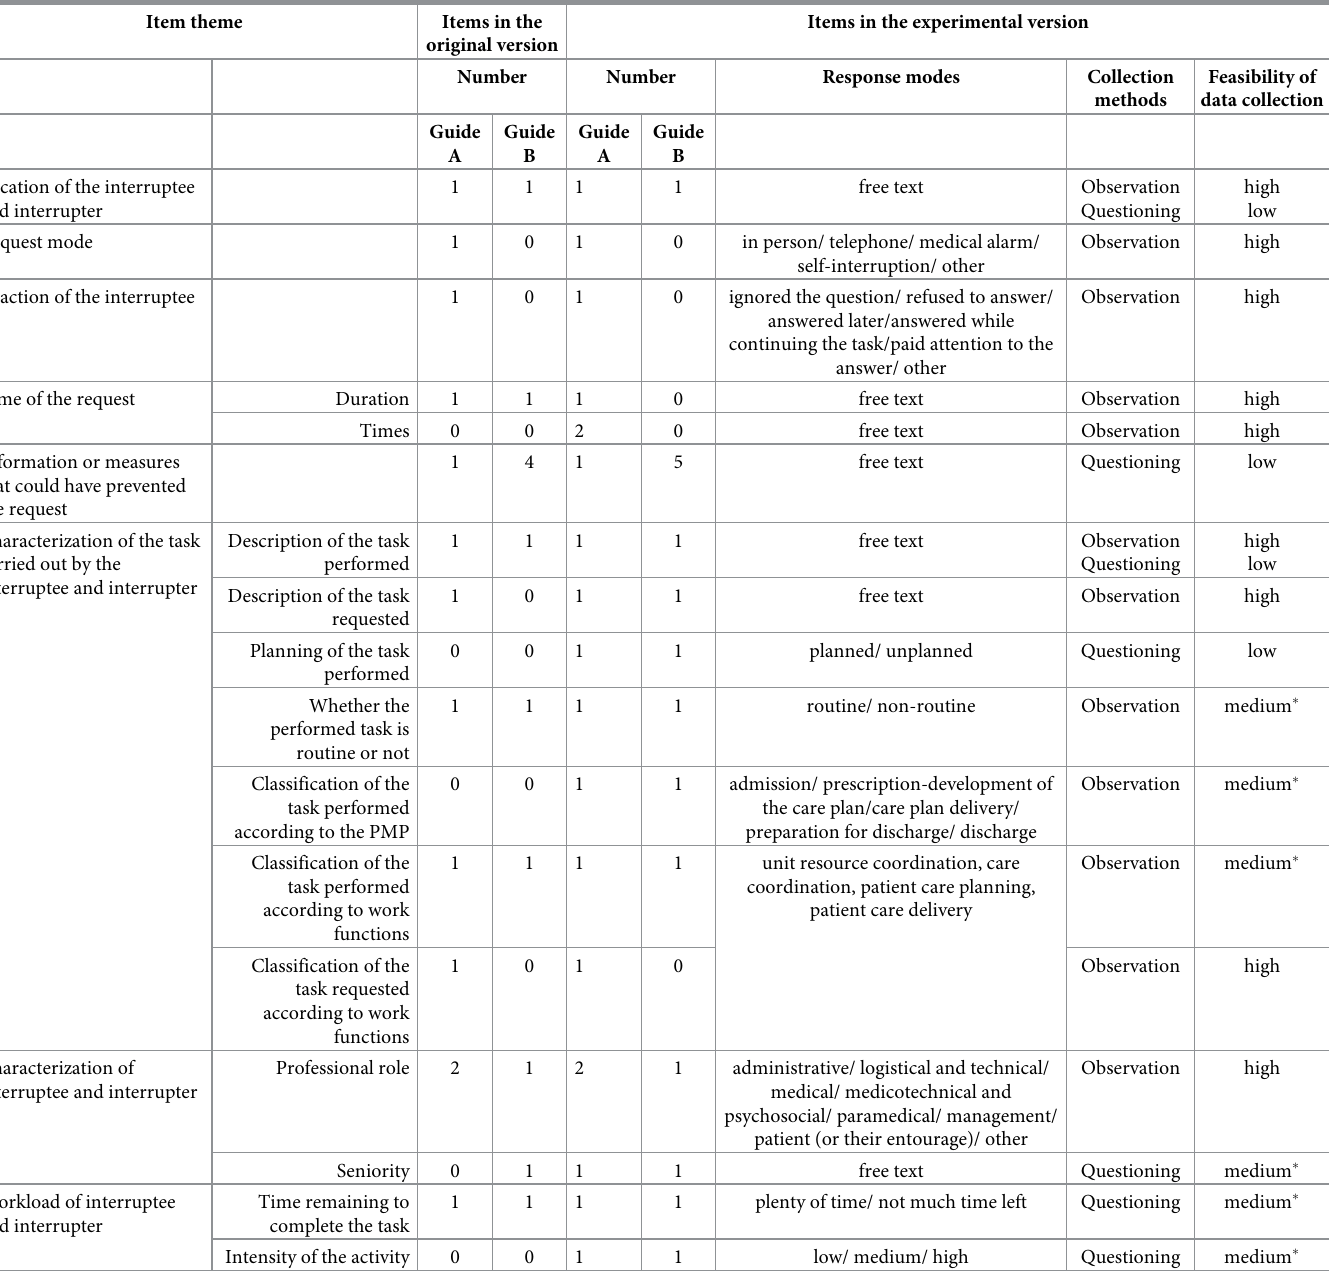
Table 1. Adaptation of the items in the data collection guide reported in McCurdie et al.